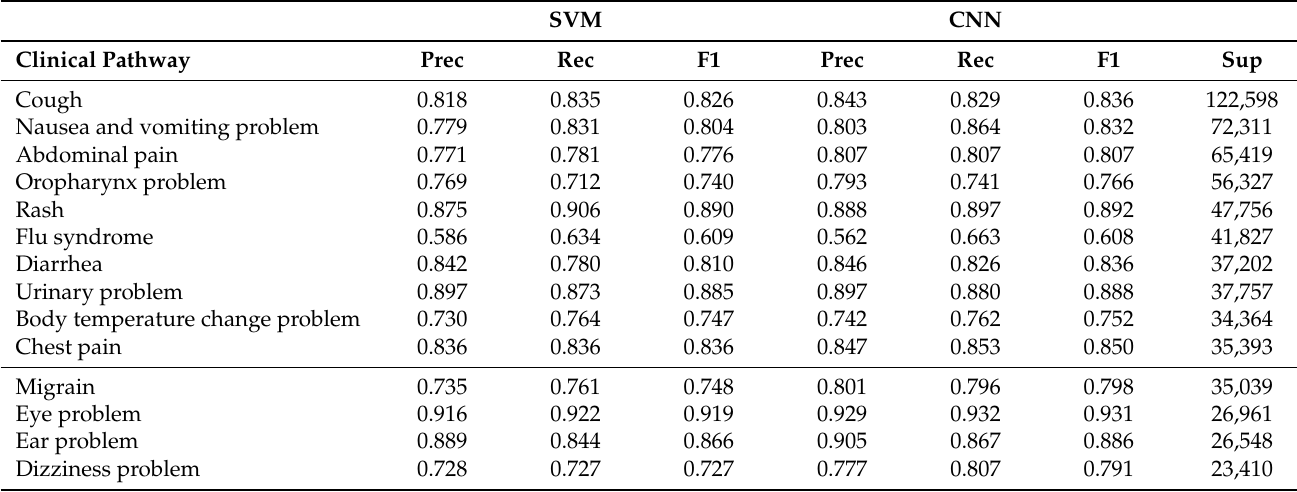
Table A2. Performance values (precision, recall and F1) for the 2017–2018 SVM and CNN